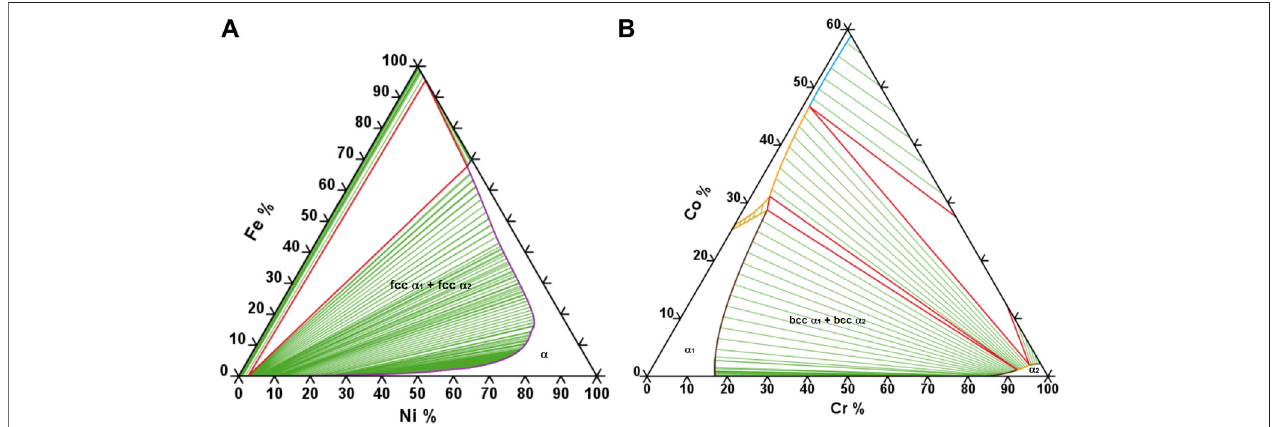
FIGURE 14 | Calphad-calculated equilibrium phase diagrams for (A) Cu – Ni – Fe and (B) Fe – Cr – Co alloy systems.